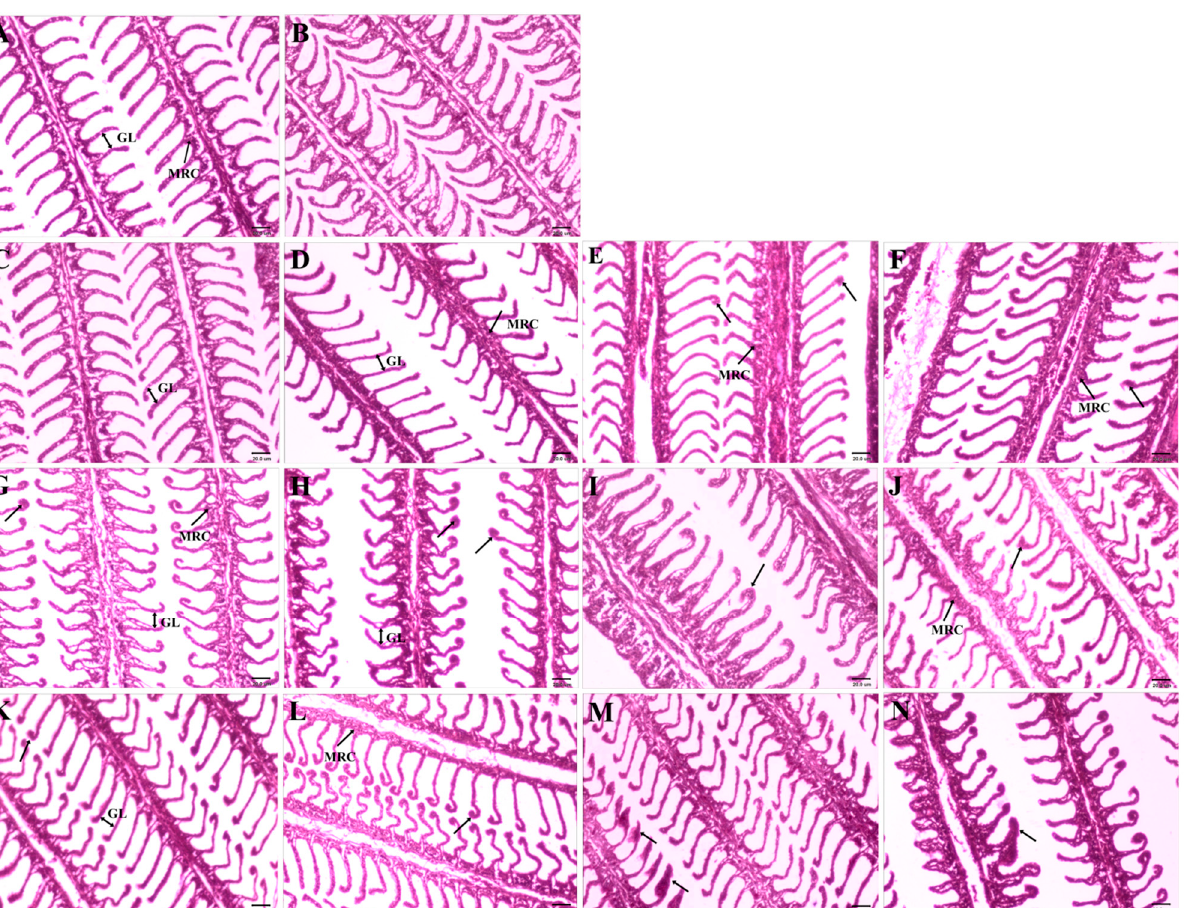
lamella (GL), mitochondrial-rich cell (MRC), and epithelial cell swelling ( ↑